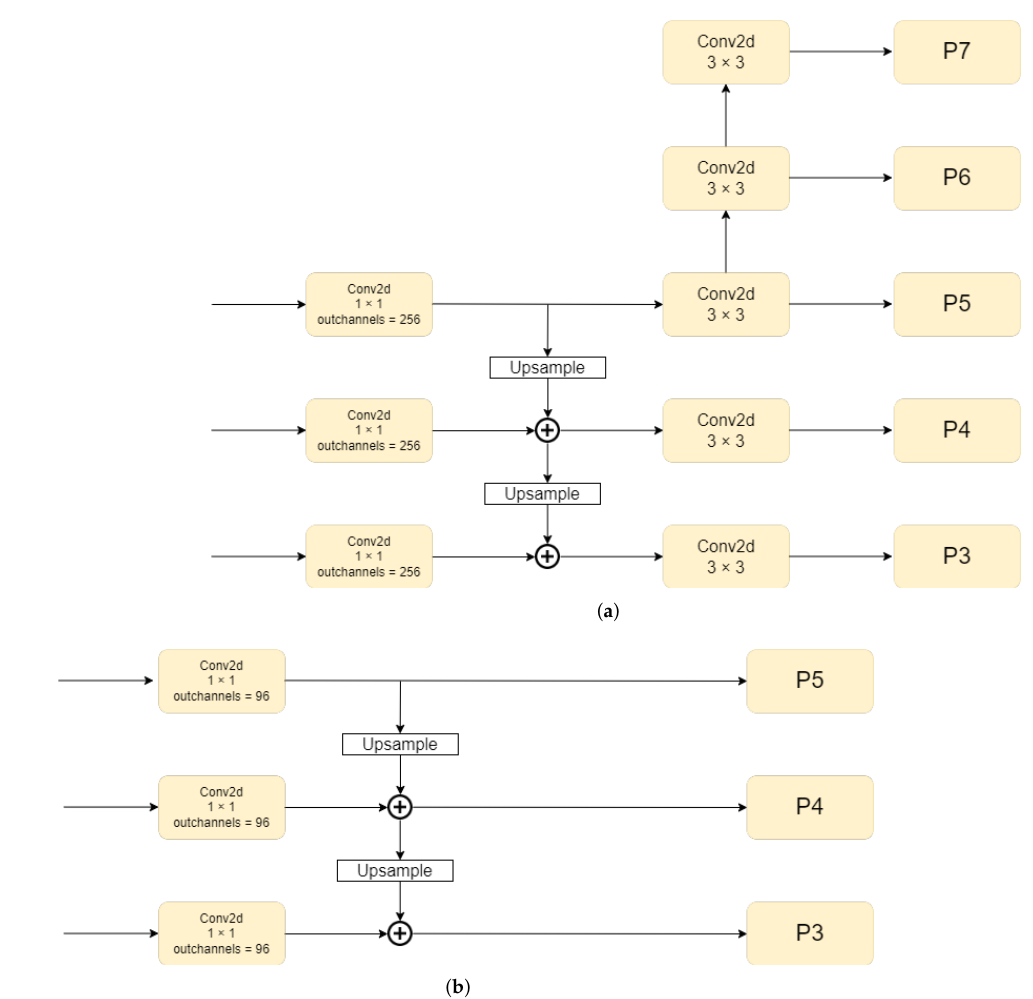
Figure 3. Architecture of ( a ) original FPN and ( b ) our proposed lightweight FPN. In the original FPN network, the output has five layers: P3 to P7. In our proposed lightweight FPN, C3, C4, and C5 are processed to obtain P3, P4, and P5, with a 1 × 1 convolution and an up-sampling